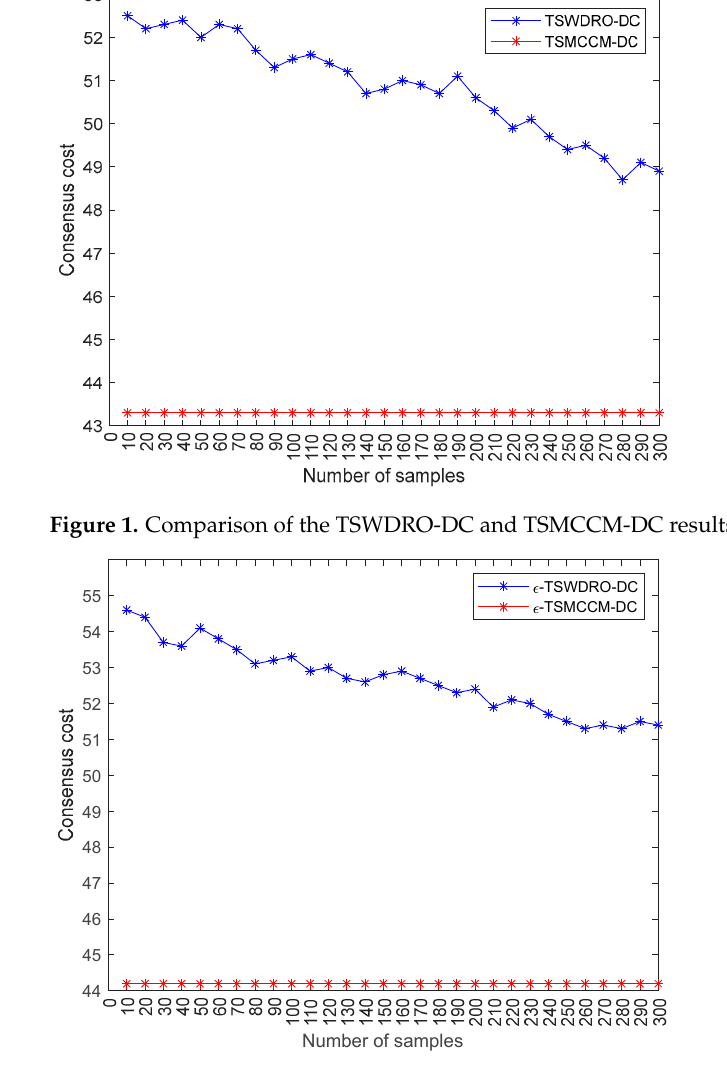
Figure 2. Comparison of the